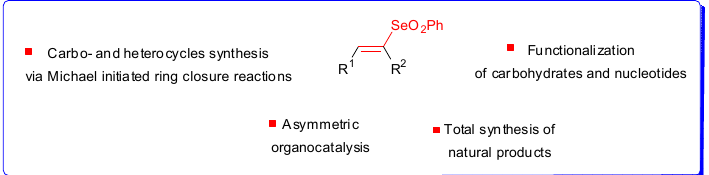
Figure 1. Vinyl selenones as versatile reagents in organic synthesis.